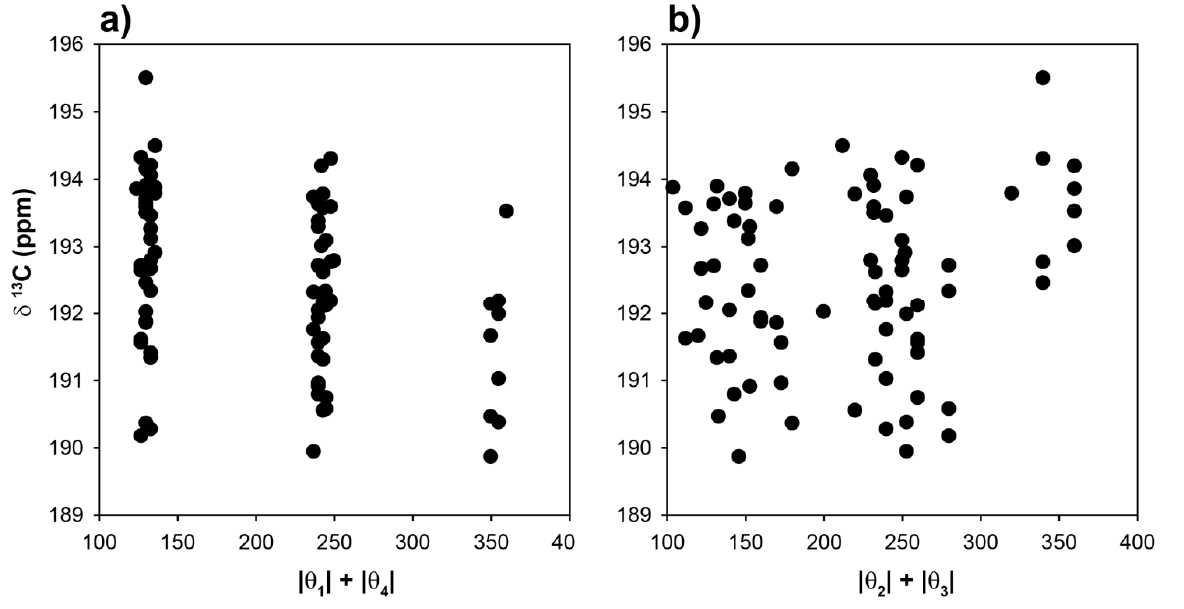
Figure 5. Predicted 13 C-NMR chemical shift variation of the carbonyl (COOH) carbon as a function of ( a ) the | θ | angle